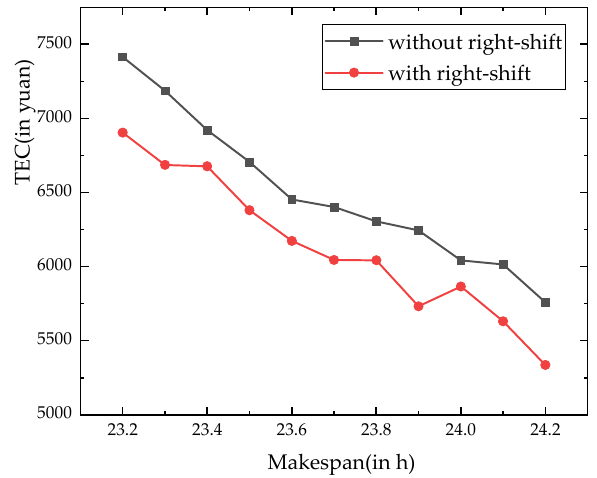
Figure 6. Pareto frontier. Figure 6. Pareto A non-dominated solution of improved NSGA-II algorithm (f1 = 23.6 h, f2 = 6173.6 yuan) corresponding to the processing sequence 8-2-10-7-5-3-12-13-14-6-4-9-11-15-1 is